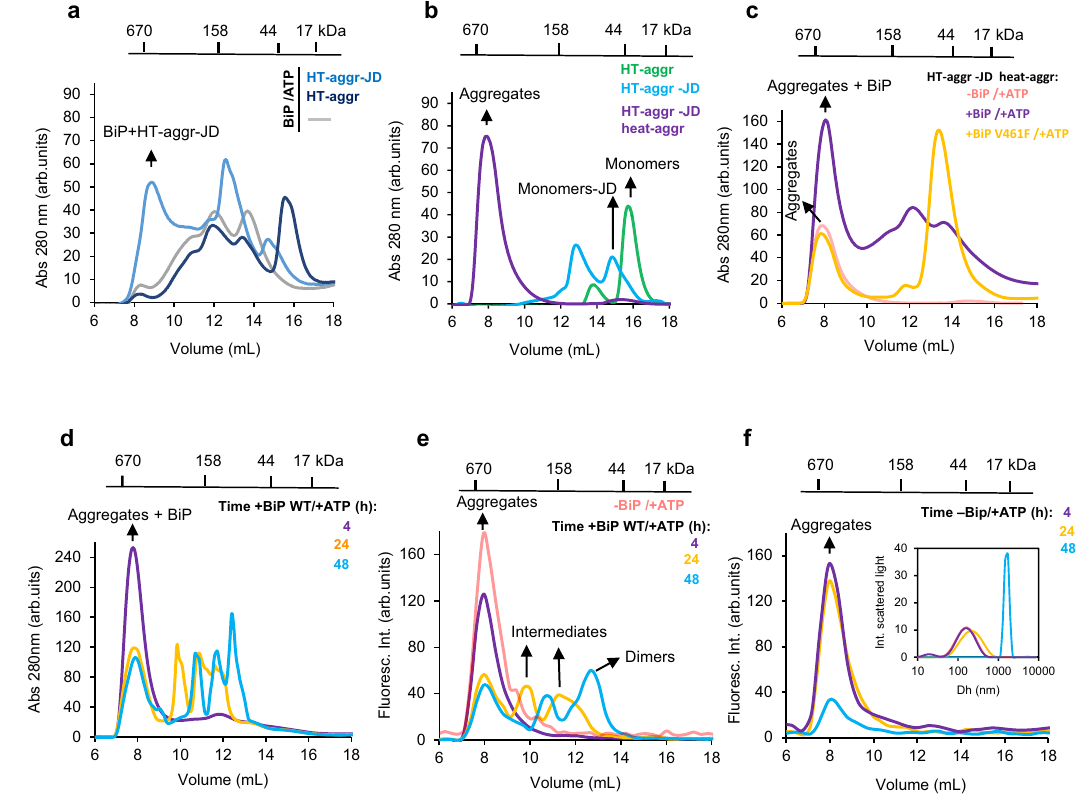
Fig. 5 ATP-driven HT-aggr disaggregation by BiP in vitro. a Protein absorbance traces (280 nm) of BiP WT (50 µ M) alone (grey), with native HT-aggr (dark blue) or native HT-aggr, fused to J-domain (HT-aggr-JD, 10 µ M) (light blue), resolved by gel fi ltration chromatography (10 – 600 kDa fractionation range). b Traces as in ( a ) of native HT-aggr (green), native HT-aggr-JD (light blue) and heat-aggregated HT-aggr-JD (53 °C, 20 min, 10 µ M) (magenta). c , Traces as in ( a , b ) of aggregated as in ( b ) HT-aggr-JD, incubated with BiP WT/ATP (magenta) or BiP V461F/ATP (orange), a substrate-binding de fi cient BiP mutant. Note the increase in the main peak of the aggregated HT-aggr-JD (pale red) upon the addition of BiP WT/ATP only, indicative of its recruitment to the aggregates. d Traces as in ( a , b ) of aggregated as in (b) HT-aggr-JD, incubated with BiP WT/ATP for the indicated periods (4 h, magenta; 24 h, orange; 48 h, light blue). e Fluorescence traces of chromatograms as in (d) this time exclusively detecting HT-aggr-JD (pre-aggregated) through the fl uorescence of its P2-halo ligand label (HT-aggr-JD, pale red; 4 h, magenta; 24 h, orange; 48 h, light blue). f Fluorescence traces of chromatograms for the P2-labelled HT-aggr-JD (pre-aggregated) in the absence of BiP for the same time course and trace ’ s colours as in ( e ). Fluorescence was measured for discrete data points, 0.3 mL each. Dynamic light scattering measurements showing the hydrodynamic diameter (Dh) of P2-labelled HT-aggr-JD (pre-aggregated) for the same time course were plotted in the inset to unveil the growth of the aggregates in the absence of BiP and explain why aggregates are retained in the pre- fi lter of the column leading to a decreased amount eluted over time. The measurements in ( a – f ) were performed in the presence of ATP (3 – 9 mM), which elutes at 20.2 mL, fractions omitted from the chromatogram.